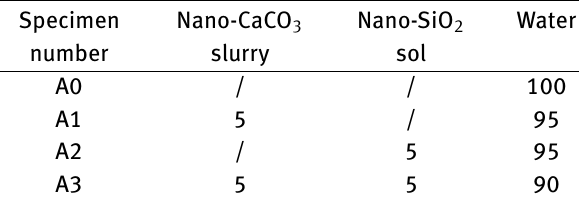
Table 1: Proportion of the Immersion solutions (%)